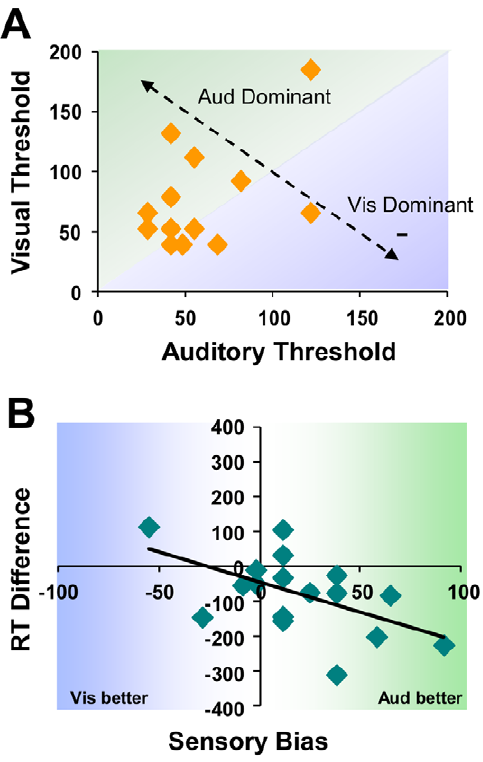
Figure 5. Temporal thresholds and the relation to RT. Temporal thresholds for each modality derived prior to the study (via staircase procedure) show no systematic relationship across subjects ( A ). Shaded areas represent whether a subject shows more temporal acuity in the visual (blue) or auditory (green) domain. There is, however, a high correlation between the amount of sensory bias (difference between visual and auditory thresholds) observed and reaction time differences across subjects ( B